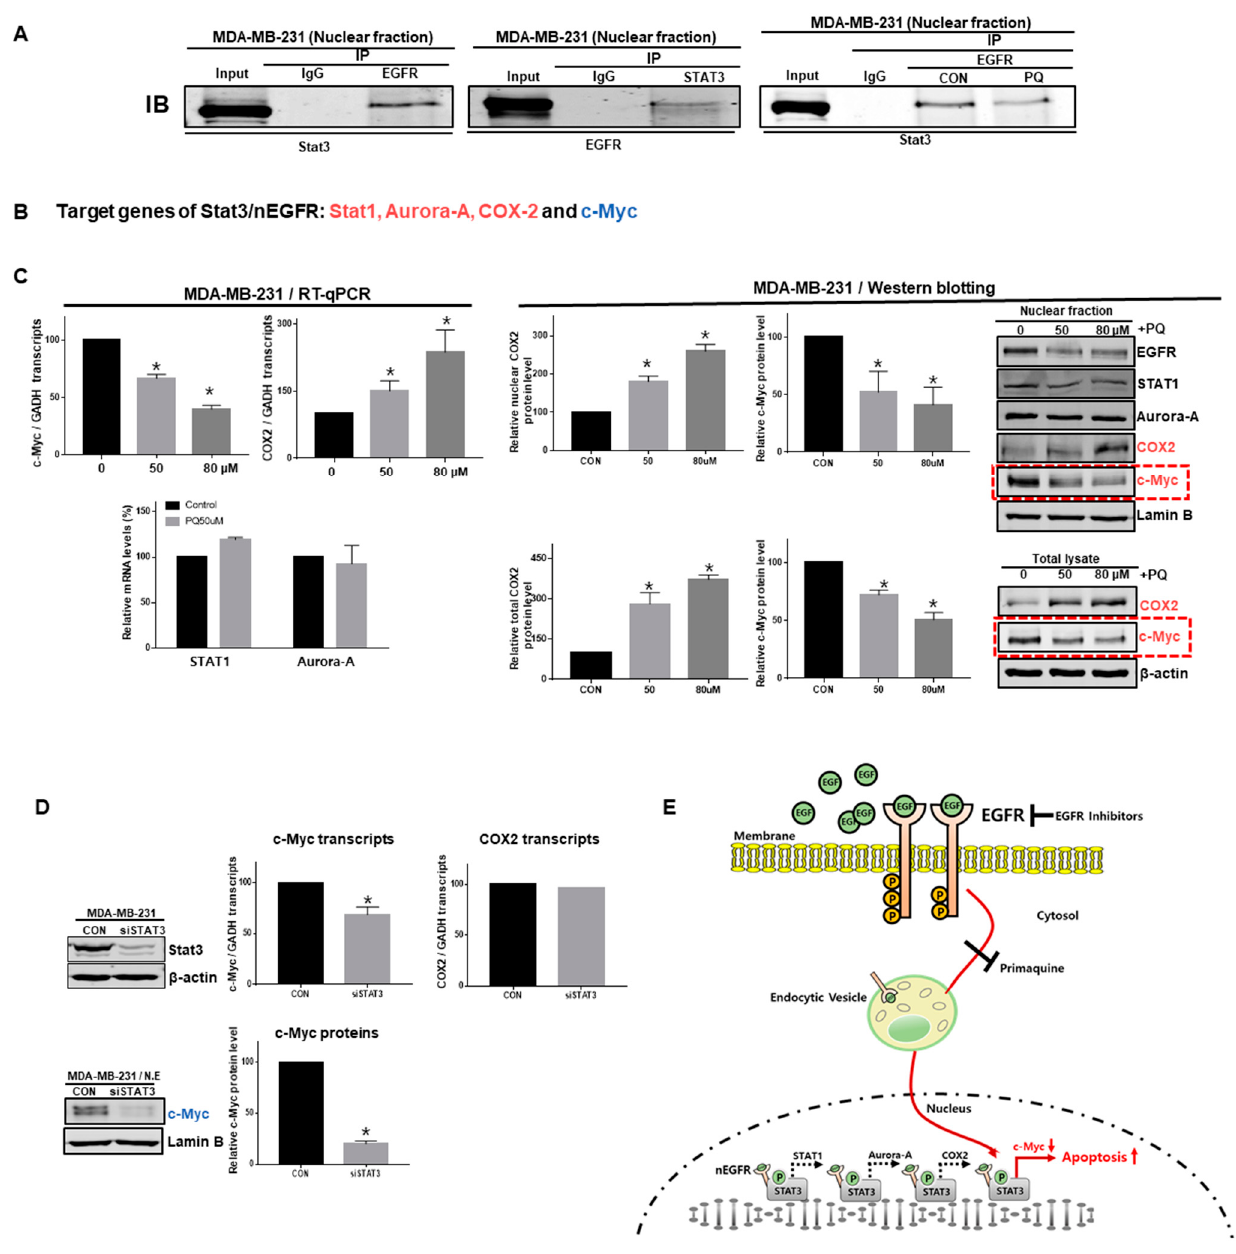
Figure 5. Primaquine reduced the interaction of nEGFR and Stat3 and reduced the transcript and protein levels of c-Myc. ( A ) nEGFR and Stat3 were immunoprecipitated from the nuclear protein extracts of breast cancer cells under primaquine treatment with anti-EGFR or anti-Stat3 antibodies. Western blotting was performed using the indicated antibodies. ( B ) The target genes of the Stat3/nEGFR complex were Stat1, Aurora-A, COX2, and c-Myc. ( C ) Effect of primaquine on transcript levels, total levels, and nuclear levels of the Stat1, Aurora-A, COX2, and c-Myc proteins. Total and nuclear c-Myc protein levels under primaquine (50 and 80 µM) or DMSO treatment conditions. The data are presented as the mean ± SD; n = 3; * indicates p < 0.05 vs. control. ( D ) siRNA-induced silencing of Stat3 reduced the transcript and protein levels of c-Myc. Representative images of Western blots are shown. Data from triplicate experiments are shown as the mean ± SD. Compared with control, * indicates p < 0.05. ( E ) Inhibition of nEGFR function by primaquine. EGF stimulation induces EGFR dimerization and internalization to endocytic vesicles. EGFR then undergoes nuclear translocation. EGFR is consistently detected in the nuclei of breast cancer cells. nEGFR binds to Stat3, and the EGFR/Stat3 complex regulates the transcription of Stat1, Aurora kinase A, COX2, and c-Myc. Primaquine reduces nEGFR expression by inhibiting EGFR